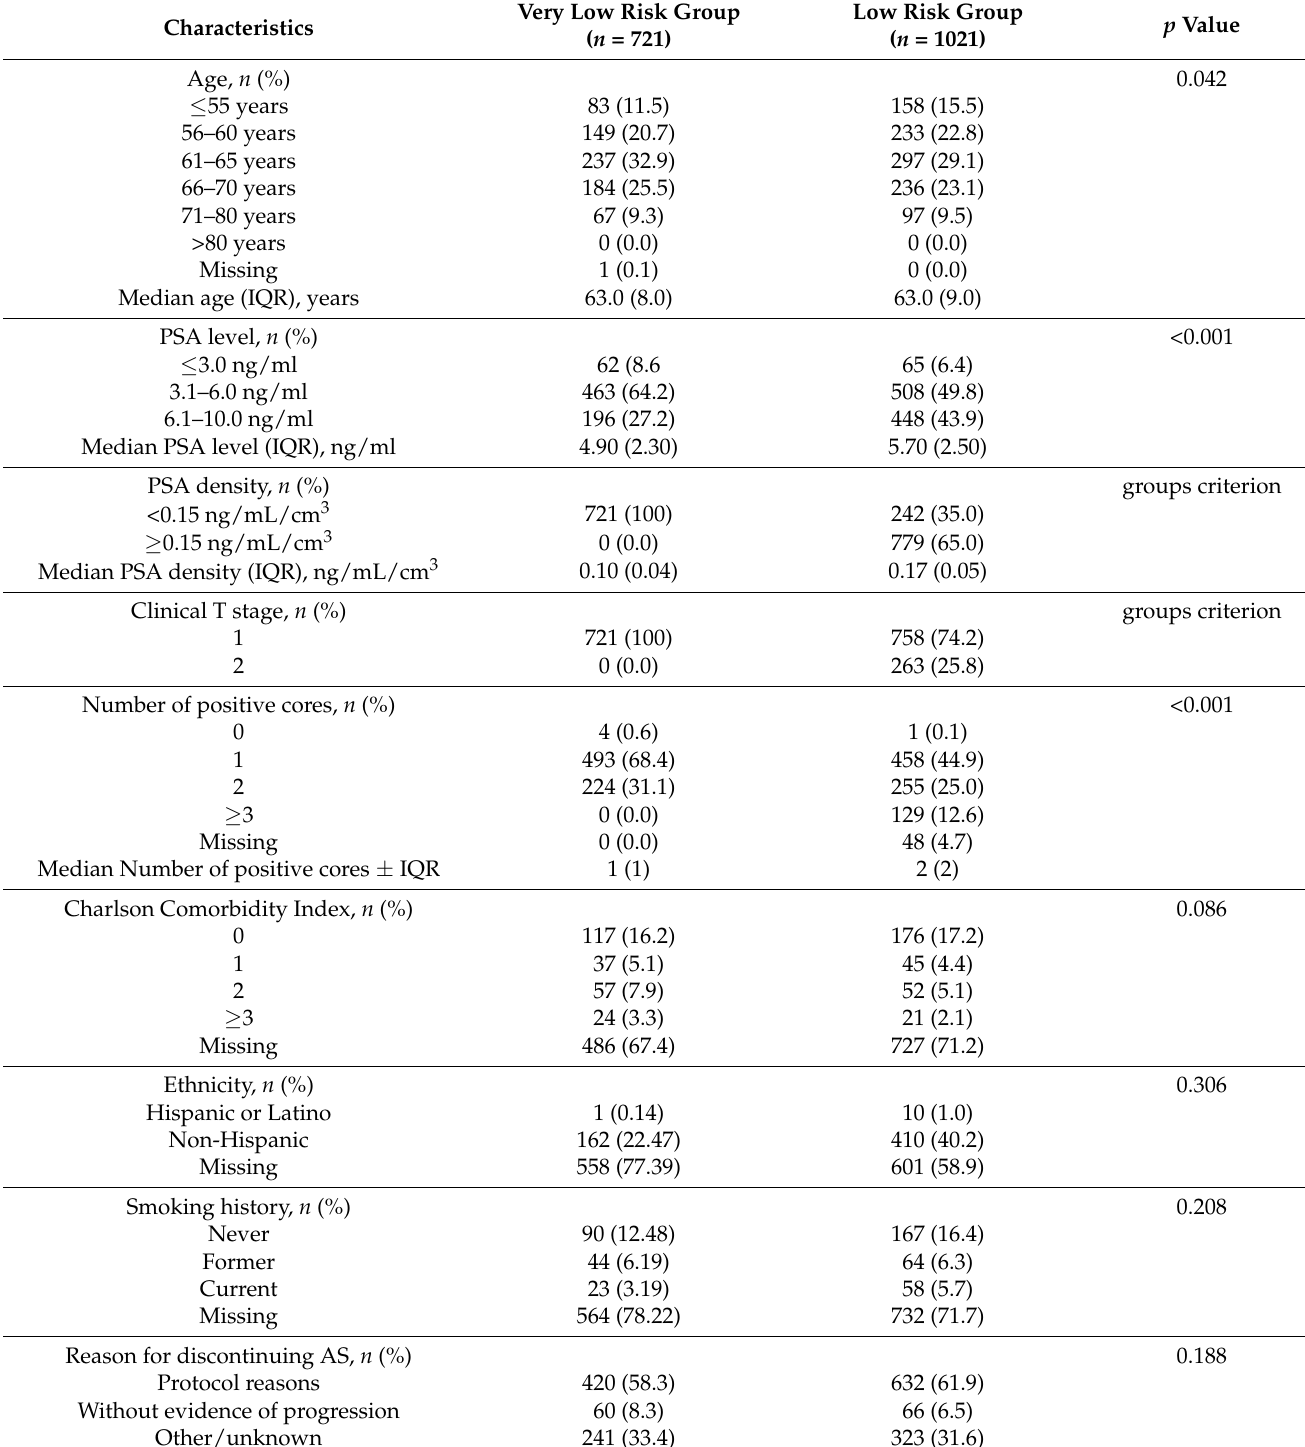
Table 1. Baseline characteristics of patients in very low risk and low risk sub-groups undergoing radical